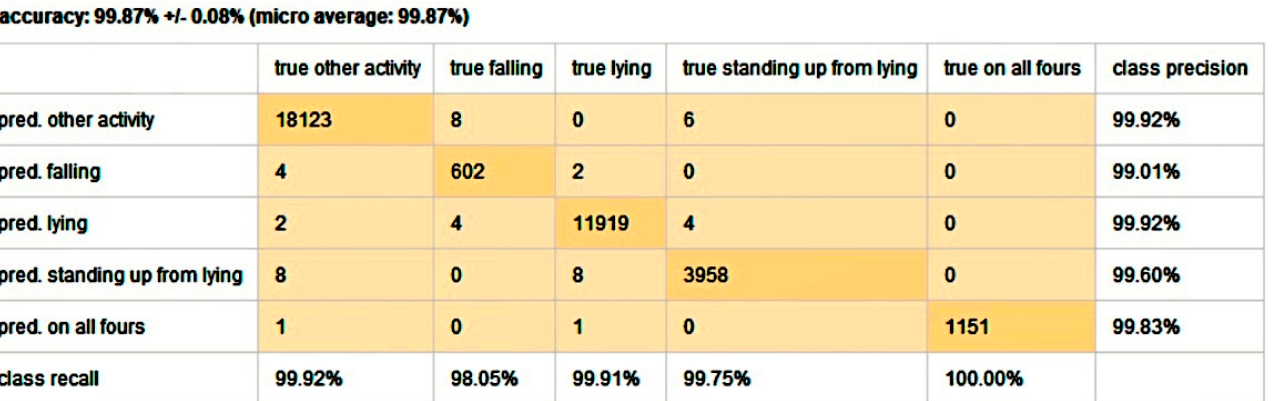
Figure 6. ( a ) The training and testing modules of the cross-validation operator from the process shown in Figure 5. ( b ) The iterative subprocess that was developed by customizing the AdaBoost operator is shown in Figure 6a.